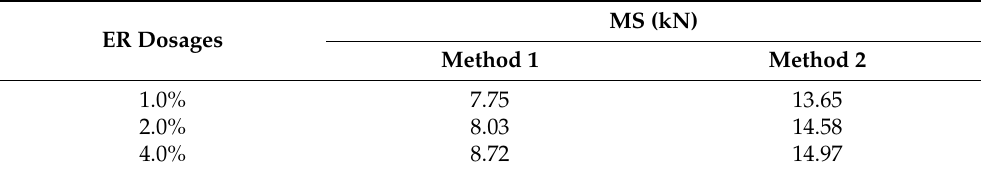
Table 10. MS of LCA-AMs prepared with different mixing methods.